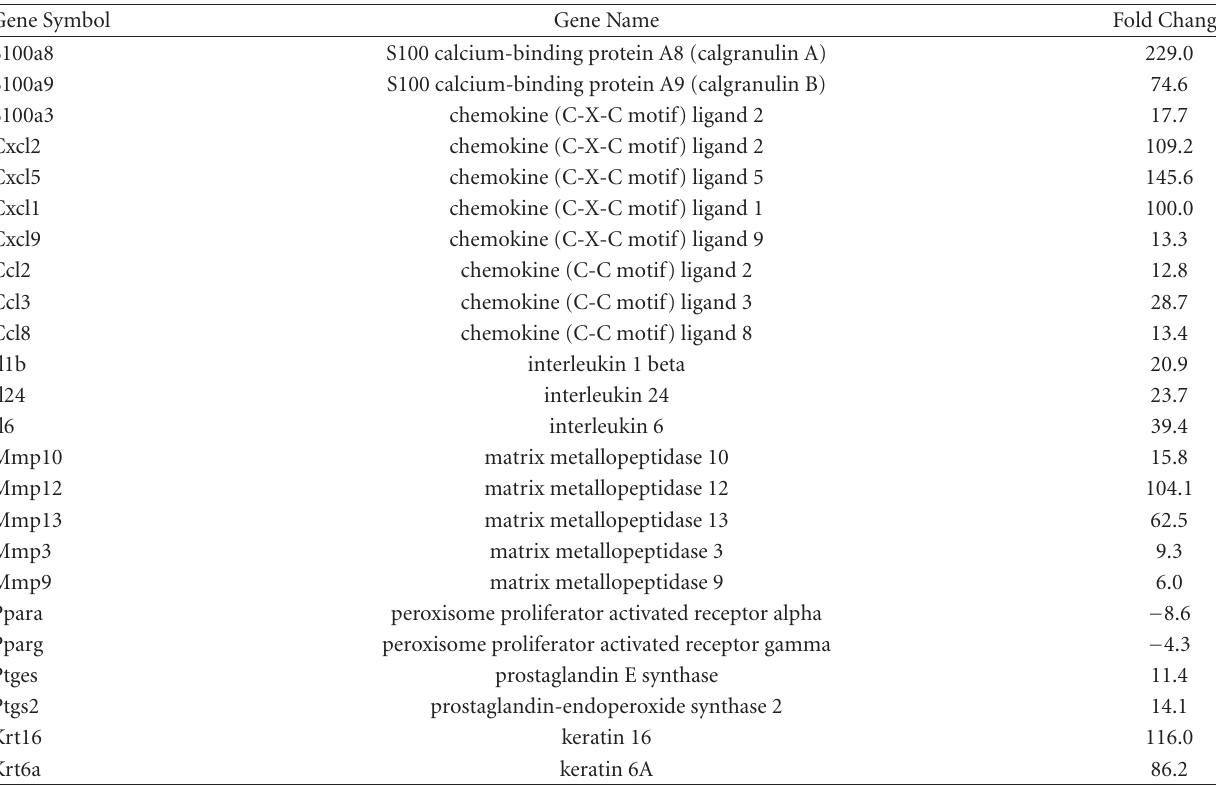
Table 2: Di ff erentially expressed genes in gastric